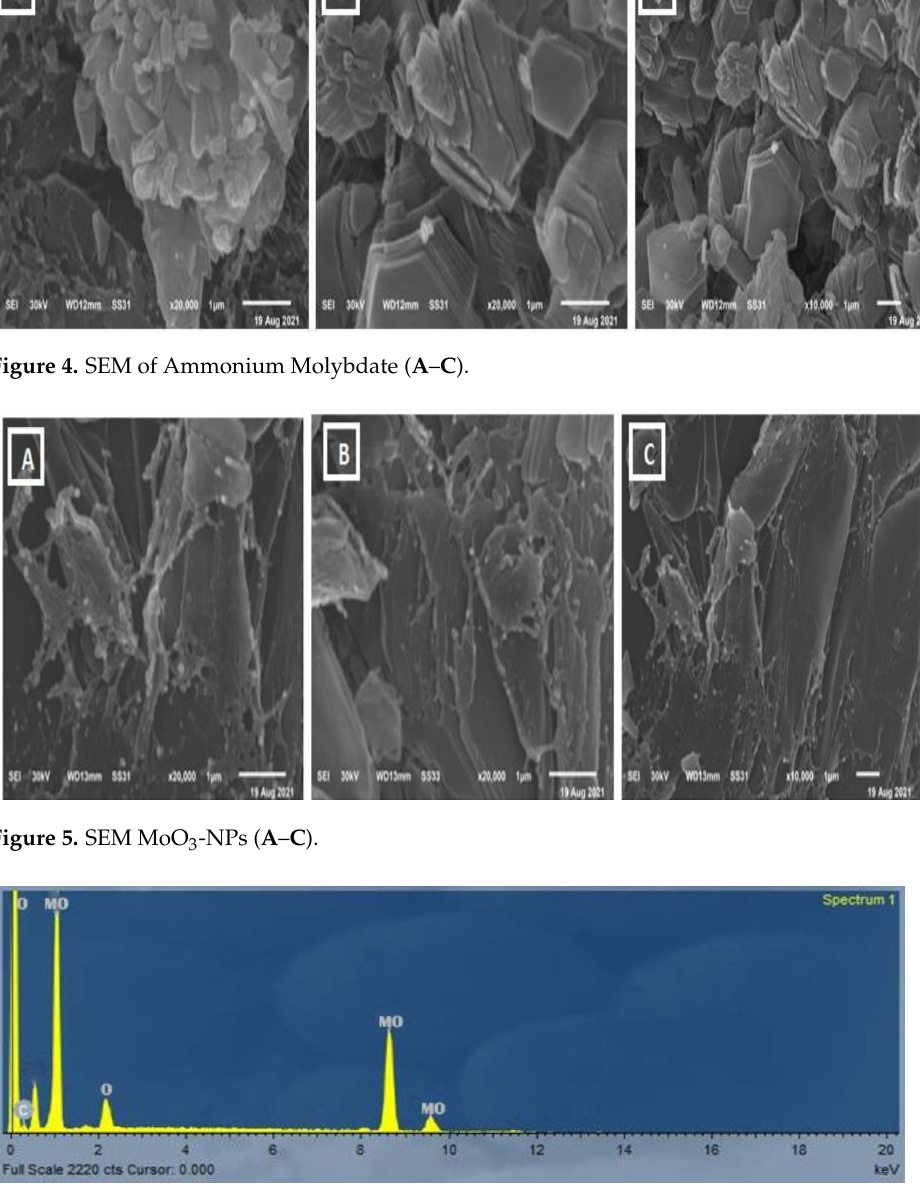
Figure 6. EDX of MoO 3